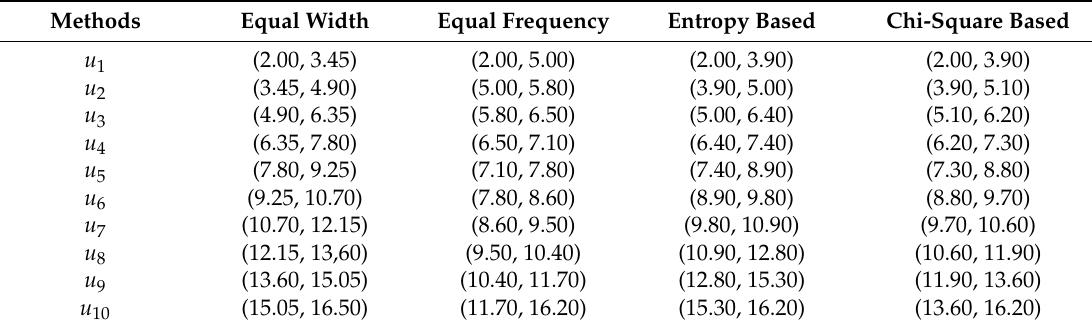
Table 3. The intervals of the four interval partitioning